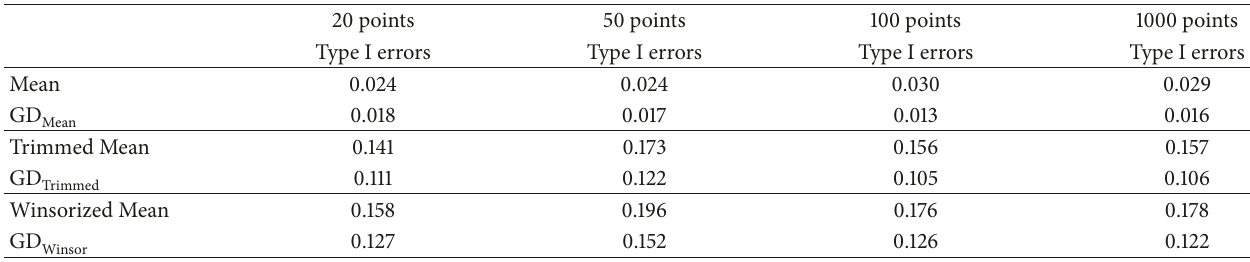
Table 36: Exponential distributions with 50% noise level.